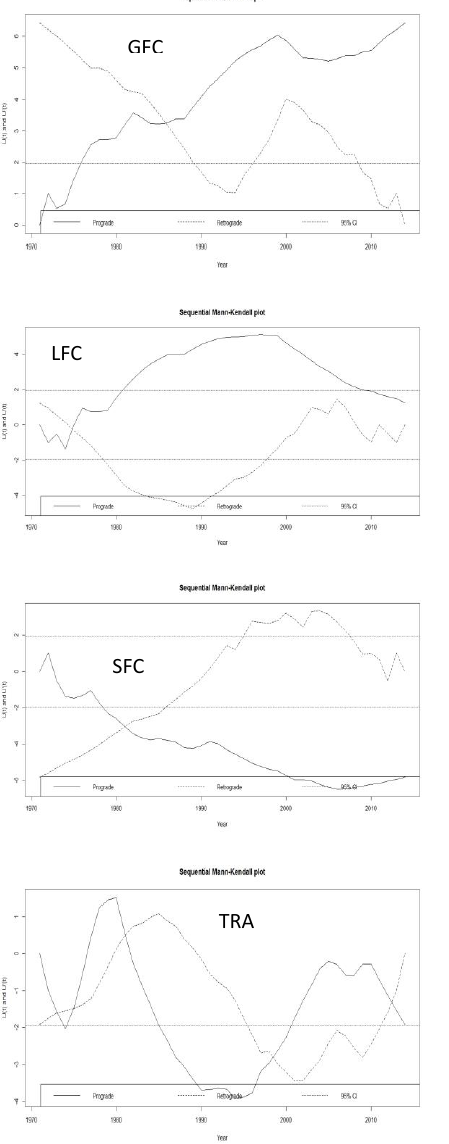
Figure 4. Sequential trend-change-detection